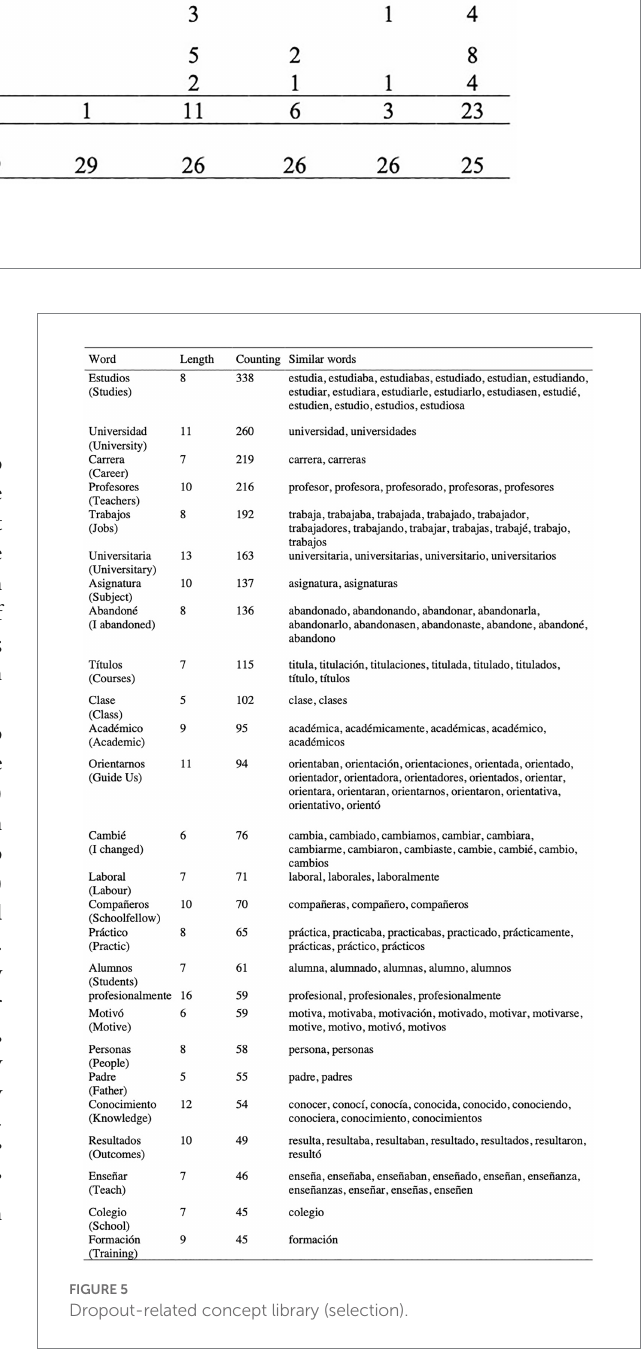
FIGURE 5 Dropout-related concept library